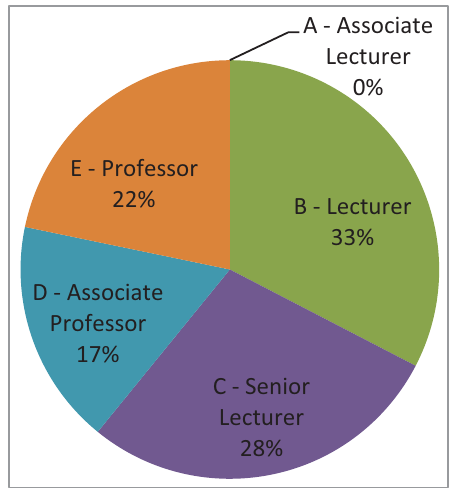
(Colour online) Positions in higher education participants held at the time of